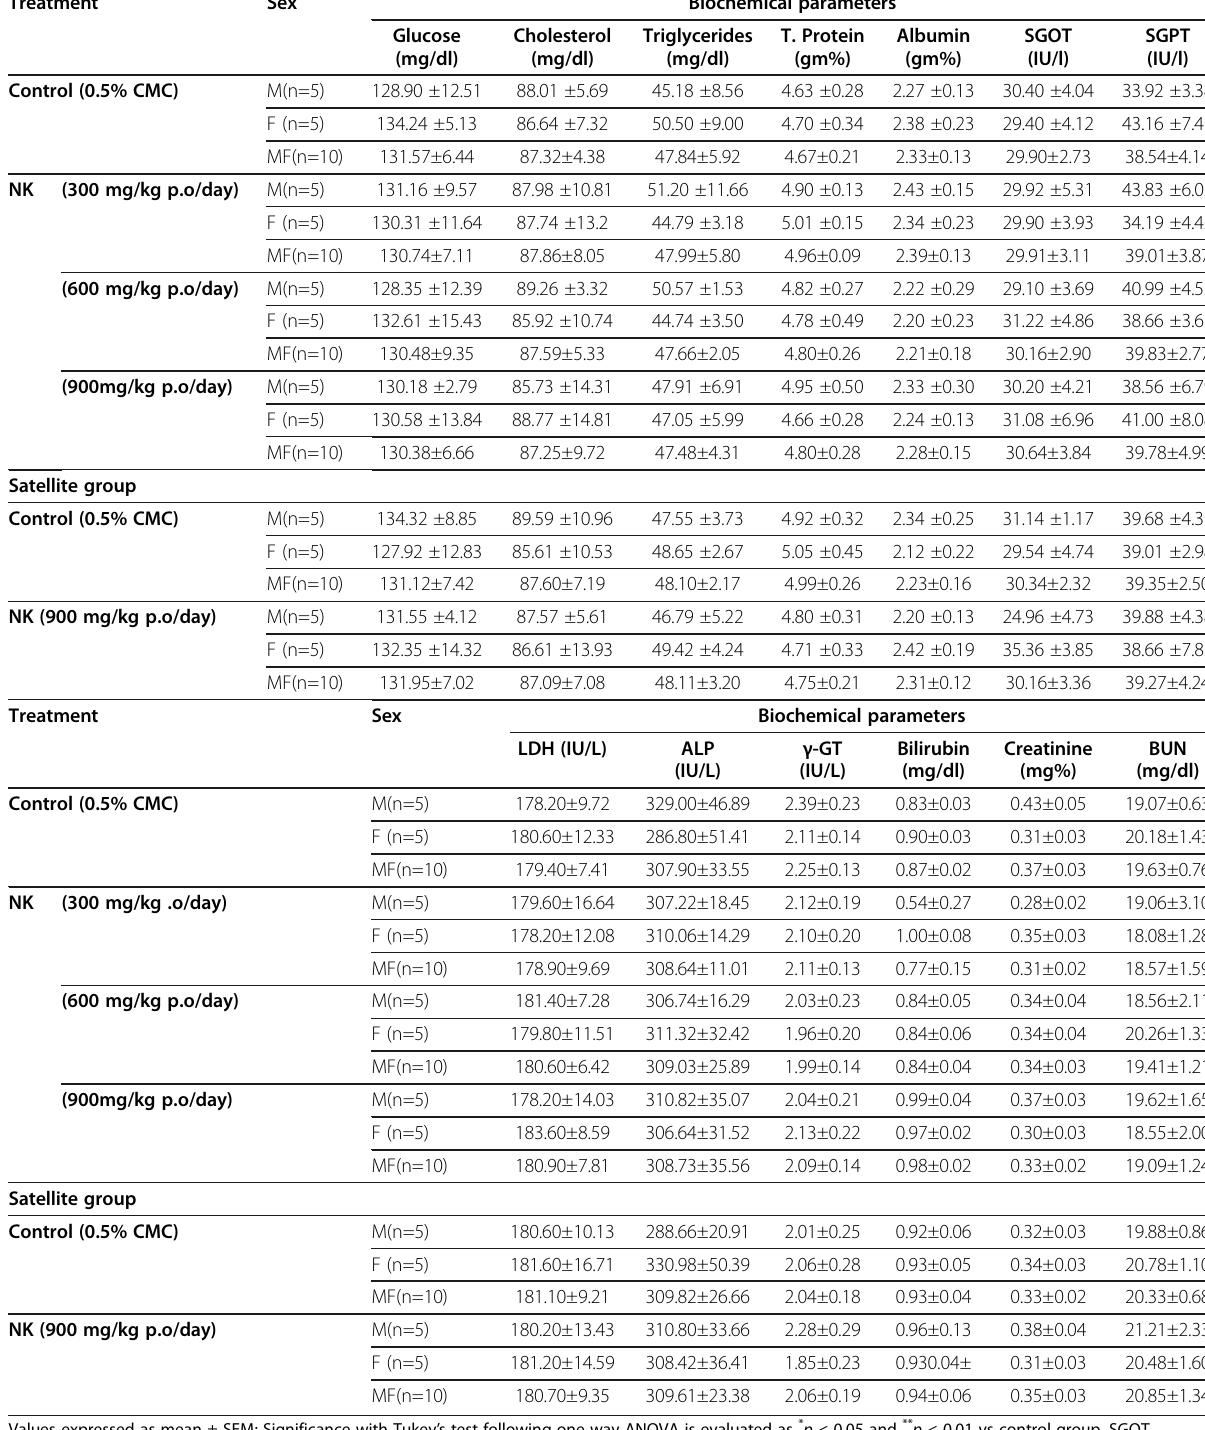
Table 8 Effect of Nuna kadugu on biochemical parameters of experimental Sprague Dawley rats in repeated oral toxicity study